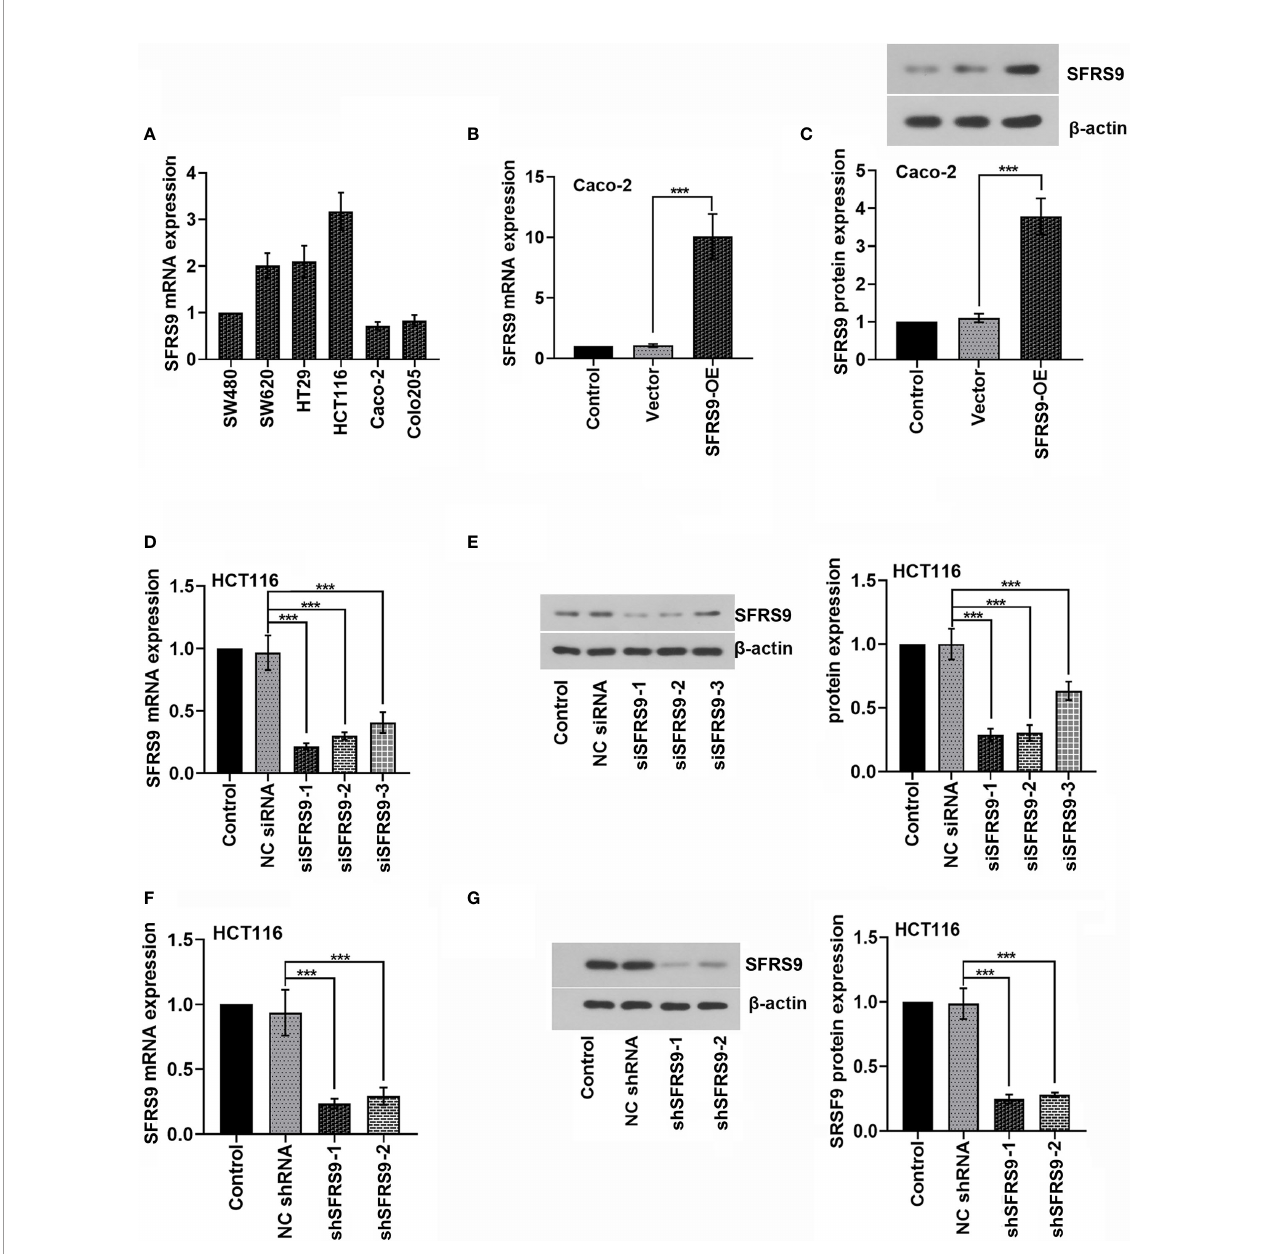
FIGURE 2 | SFRS9 expression in colorectal (CRC) cells and inhibition of SFRS9 using RNAi. (A) qRT-PCR analysis of SFRS9 mRNA expression in the CRC lines. (B, C) mRNA and protein levels of SFRS9 in Caco-2 cells transfected with SFRS9 overexpression (SFRS9-OE) vector. (D, E) qRT-PCR and western blot analysis indicating the ef fi ciency of siRNAs transfection in HCT116 cells. (F, G) shRNA speci fi c for SFRS9 was designed. qRT-PCR and western blotting analysis indicated the ef fi ciency of shRNAs transfection in HCT116 cells. Values are mean ± SD. ***p <